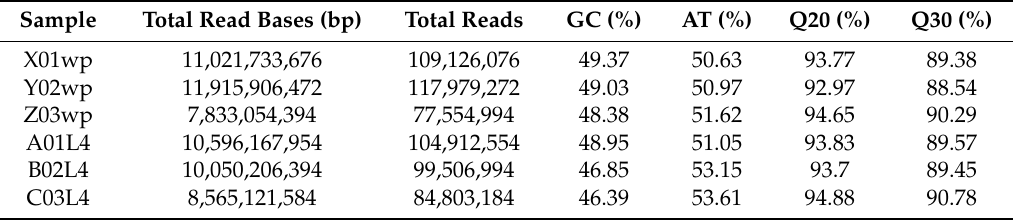
Table 1. Individual sample sequencing statistics. Samples with names ending in wp are pupal samples, those with names ending in L4 are larvae. Numerals in sample names designate source laboratory colony.